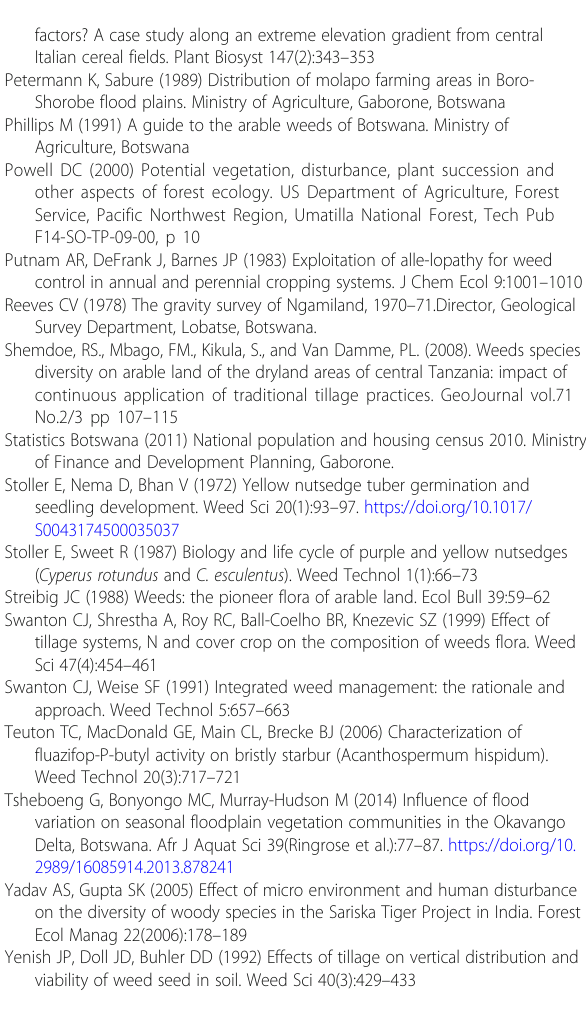
Streibig JC (1988) Weeds: the pioneer flora of arable land. Ecol Bull 39:59 – 62 Swanton CJ, Shrestha A, Roy RC, Ball-Coelho BR, Knezevic SZ (1999) Effect of tillage systems, N and cover crop on the composition of weeds flora. Weed Sci 47(4):454 – 461 Swanton CJ, Weise SF (1991) Integrated weed management: the rationale and approach. Weed Technol 5:657 – 663 Teuton TC, MacDonald GE, Main CL, Brecke BJ (2006) Characterization of fluazifop-P-butyl activity on bristly starbur (Acanthospermum hispidum). Weed Technol 20(3):717 – 721 Tsheboeng G, Bonyongo MC, Murray-Hudson M (2014) Influence of